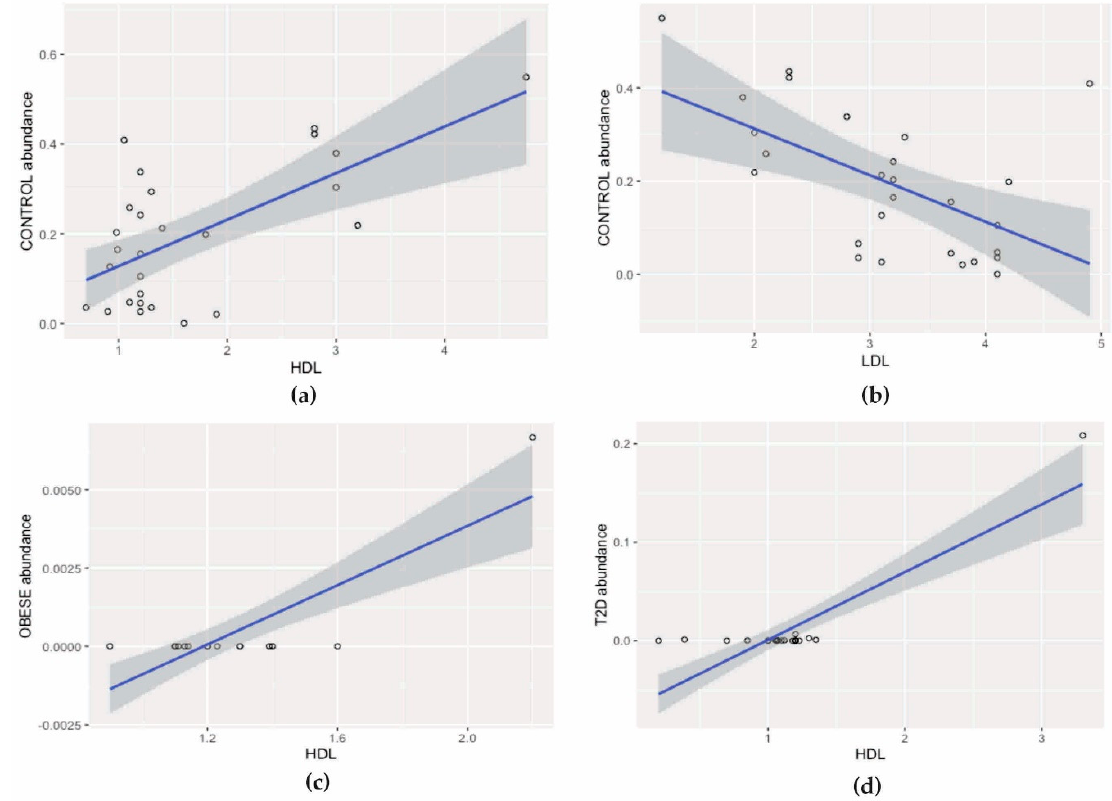
Figure 6. Correlation analysis: ( a ) positive correlation between HDL concentration and Lactobacillales, ( b ) negative correlation between Lactobacillales and LDL, ( c ) positive correlation between HDL concentration and Lactococcus , and ( d ) positive correlation between Bifidobacterium and HDL concentration. HDL: high density lipoprotein LDL: low density lipoprotein No statistically significant correlations were observed for the remaining parameters.